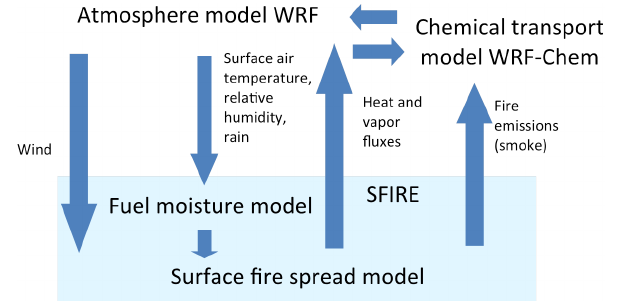
Fig. 1. The overall scheme of WRF-SFIRE. Figure 2. The overall scheme of